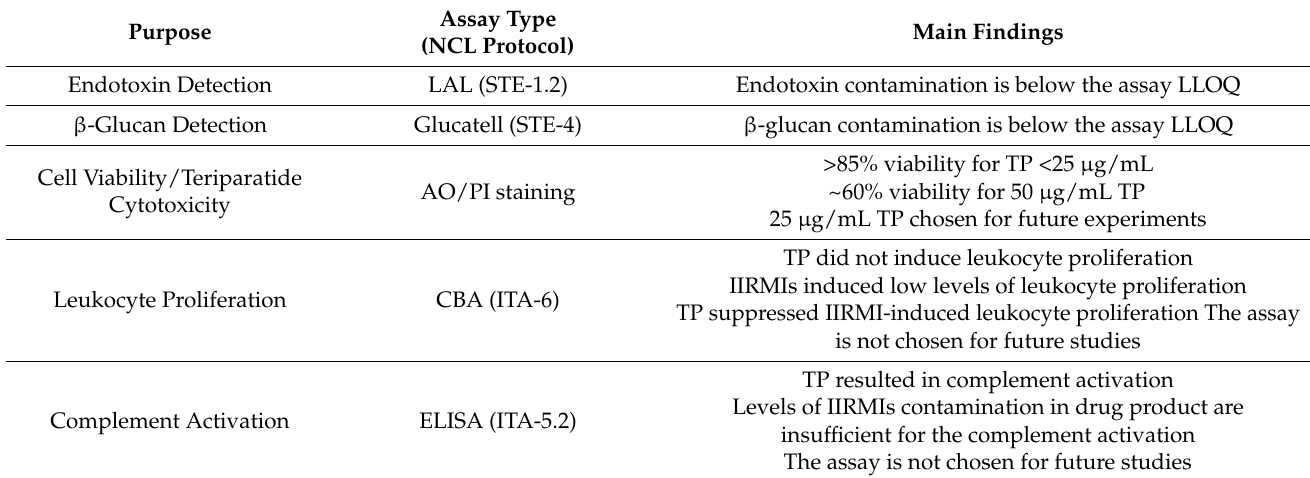
Table 1. Initial Characterization of Teriparatide. Teriparatide (TP) purity and capability of triggering innate immunity activation in vitro, either due to the presence of innate immune response modulating impurities (IIRMIs) in the drug formulation or due to the presence of the drug itself, was assessed through the following assays. Results were below the level of detection, so these assays were not used for future TP immunity experiments. LAL = Limulus Amoebocyte